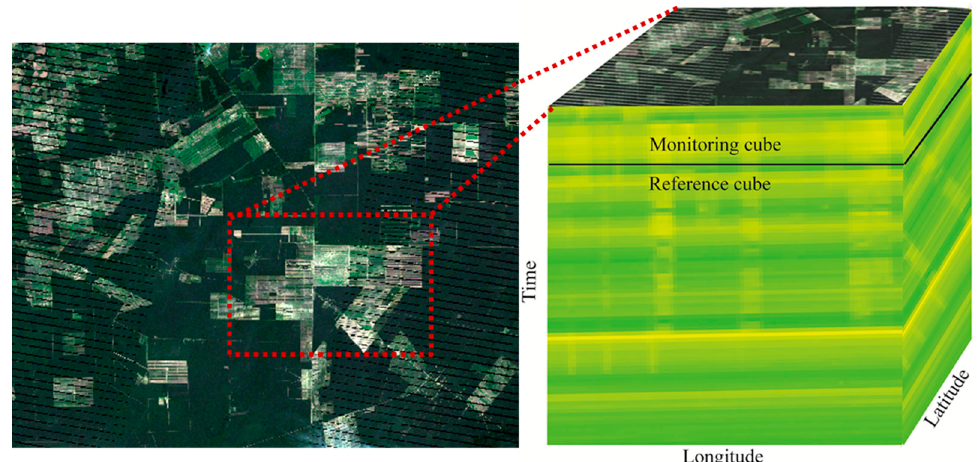
Figure 2. An example of a local space-time data cube for normalised difference vegetation index (NDVI) derived from a stack of Landsat images for the period of 2004–2014. The data cube moves across the image stack (moving window), and it is split into a reference and monitoring cube. The NDVI values in the cube are not yet deseasonalised. The horizontal banding in the cube shows the effect of seasonal variations, with yellowish tones representing the dry season.